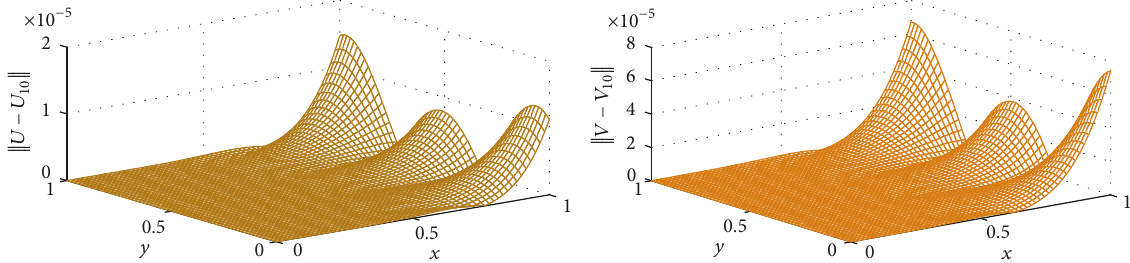
Figure 4: The maximum absolute error in 𝑈(𝑥, 𝑦) and 𝑉(𝑥, 𝑦) at 𝐾 = 10 of Problem 2.